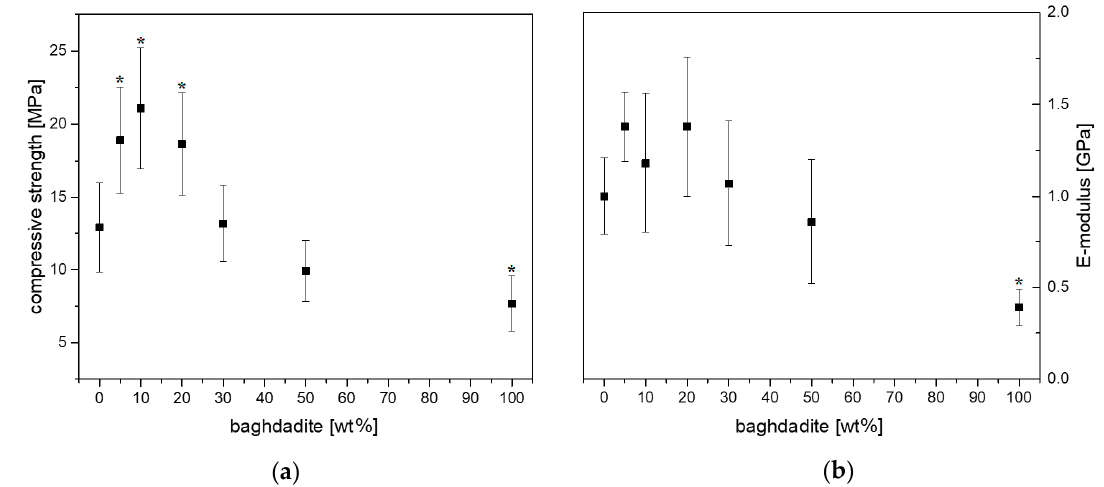
Figure 2. Compressive strength ( a ) and E-modulus ( b ) with different amount of baghdadite substitution of beta-TCP in brushite cement formulations. *: p < 0.05 versus pure set brushite cement.